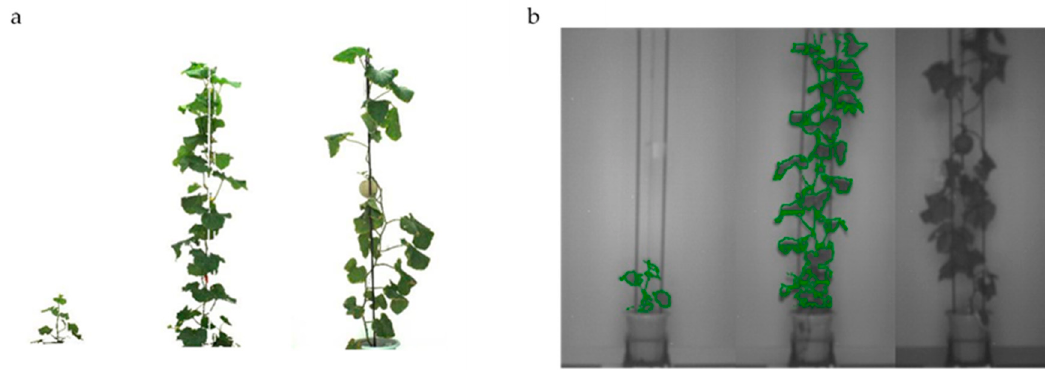
Figure 3. Muskmelon images acquired by Scanalyzer 3D (Lemna, Würselen, Germany) within visible ( a ) and near-infrared ( b ) spectra. From left to right of each panel were the images at seedling stage, vine elongation stage, and fruit development stage, respectively.